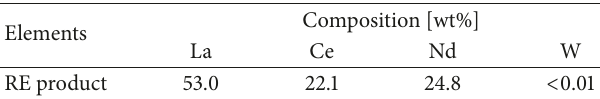
Table 2: Chemical composition of the resolidified RE metals in W crucible.